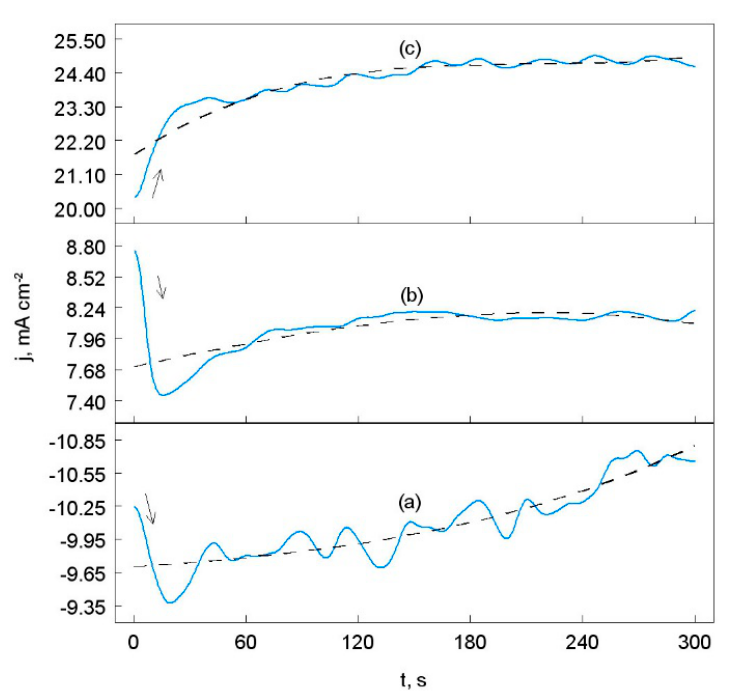
Figure 9. Chronoamperometric curves of the Al/Cu alloy after heat treatment at 400 °C, obtained for: ( a ) − 950 mV, ( b ) − 420 mV and ( c ) − 300 mV vs. the saturated calomel electrode (SCE). Solution contained 1.2 M Cl − , pH 1.5 (dashed lines refer to the average current density values). The curves (a) relate to the reduction of hydrogen ions on the surface of the working electrode [2,4]. In the case of the Al/Cu electrode after heat treatment at 400 °C an inhibitory effect of the (Al 2 O 3 -CuO) ads layer was observed. This means that the (Al 2 O 3 -CuO) ads coating was tight and the hydrogen ion reduction process was slowed down during electrolysis in the chloride environment (Figure 9, curve (a)). On the other hand after the heat treatment of the Al/Cu alloy at 600 °C a